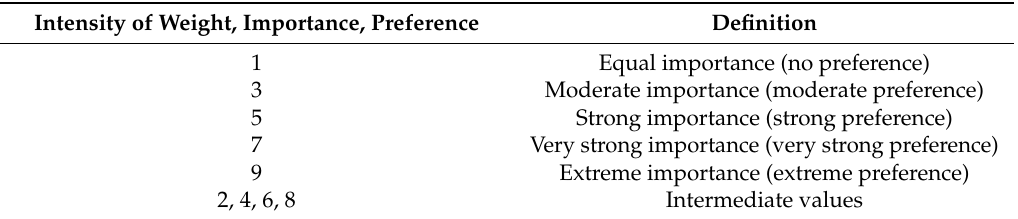
Table 5. AHP (Analytic Hierarchy Process) pair-wise comparison scale [48].